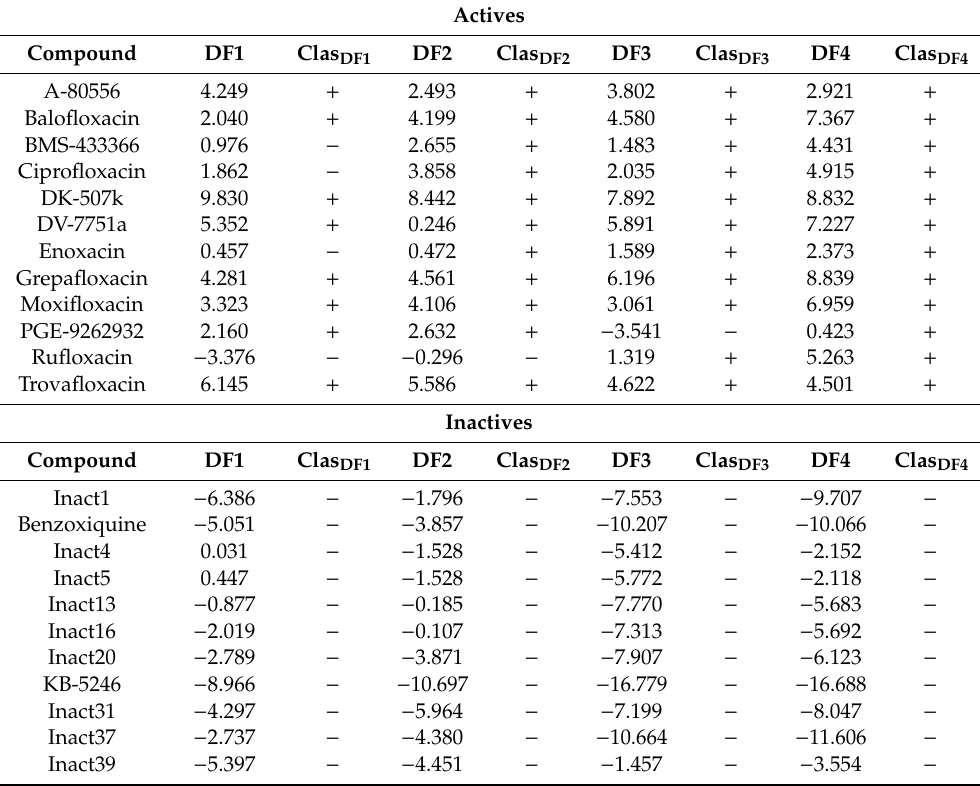
Table 7. Results obtained after combining LDA and PDD for DF1-4. Test